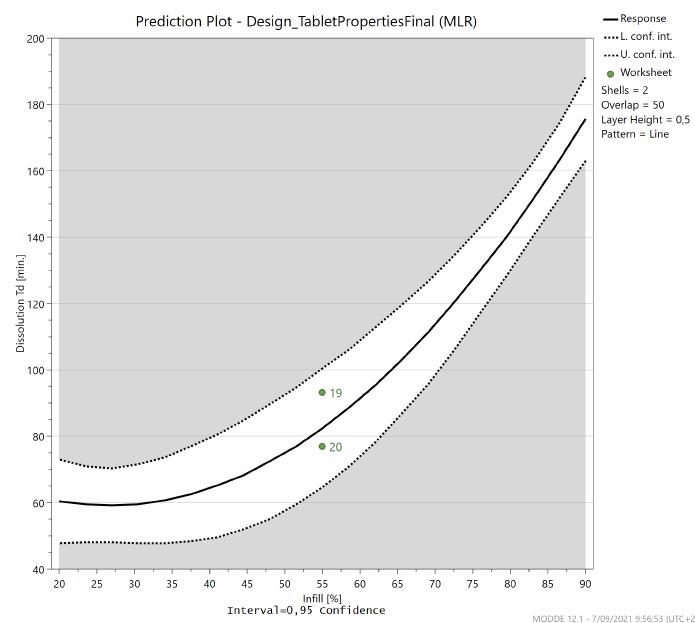
Figure 13. The prediction plot for the dissolution time (Td) in function of the infill (%) when all other factors are kept at their centre value and line pattern is